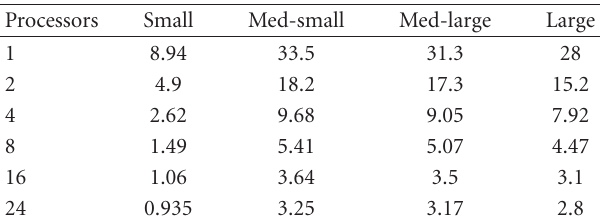
Table 3: Total timing (in hours) excluding IO operations.